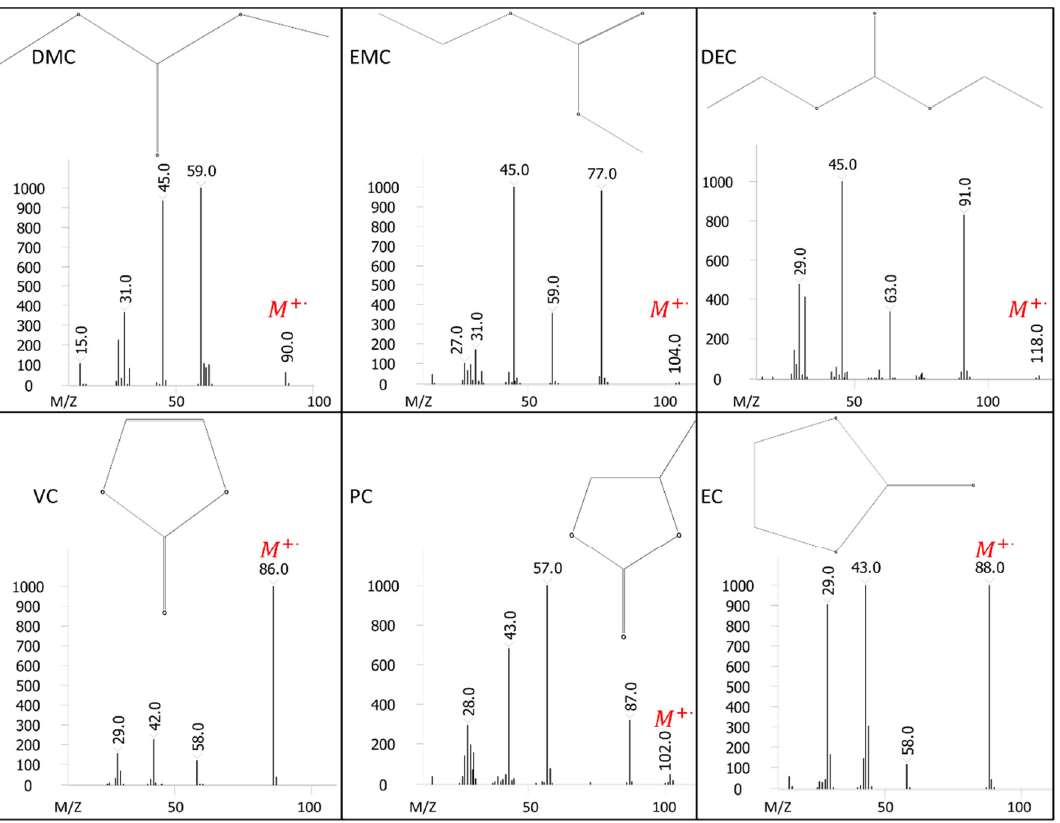
Figure 4. 70 eV EI mass spectra obtained by using GC×GC/EI TOF MS for DMC, EMC, DEC, VC, PC, and EC. Table 5. GC×GC/EI TOF MS calibration results, including the retention times and linear correlation parameters for common organic solvents found in Li-ion batteries.